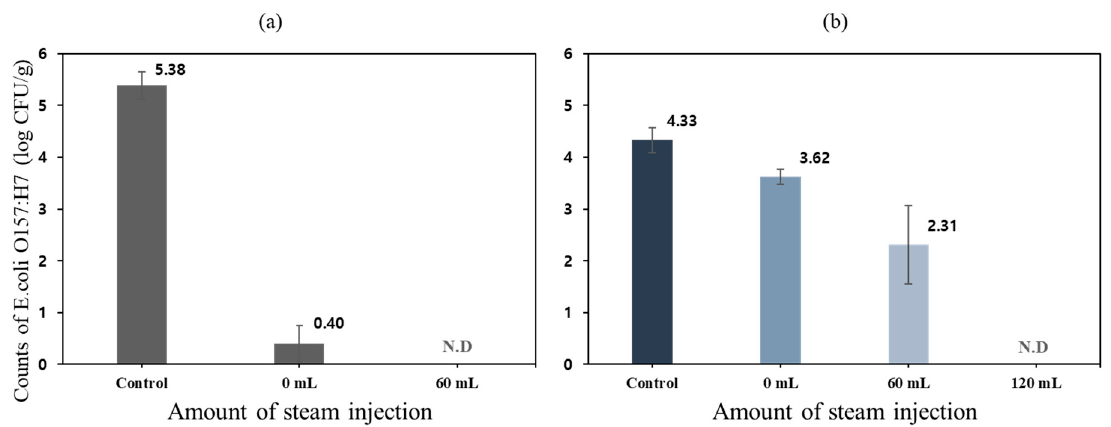
Figure 13. The inactivation rate of microbial contaminants in barely powder samples: ( a ) E. coli O157:H7 and ( b ) coliform.